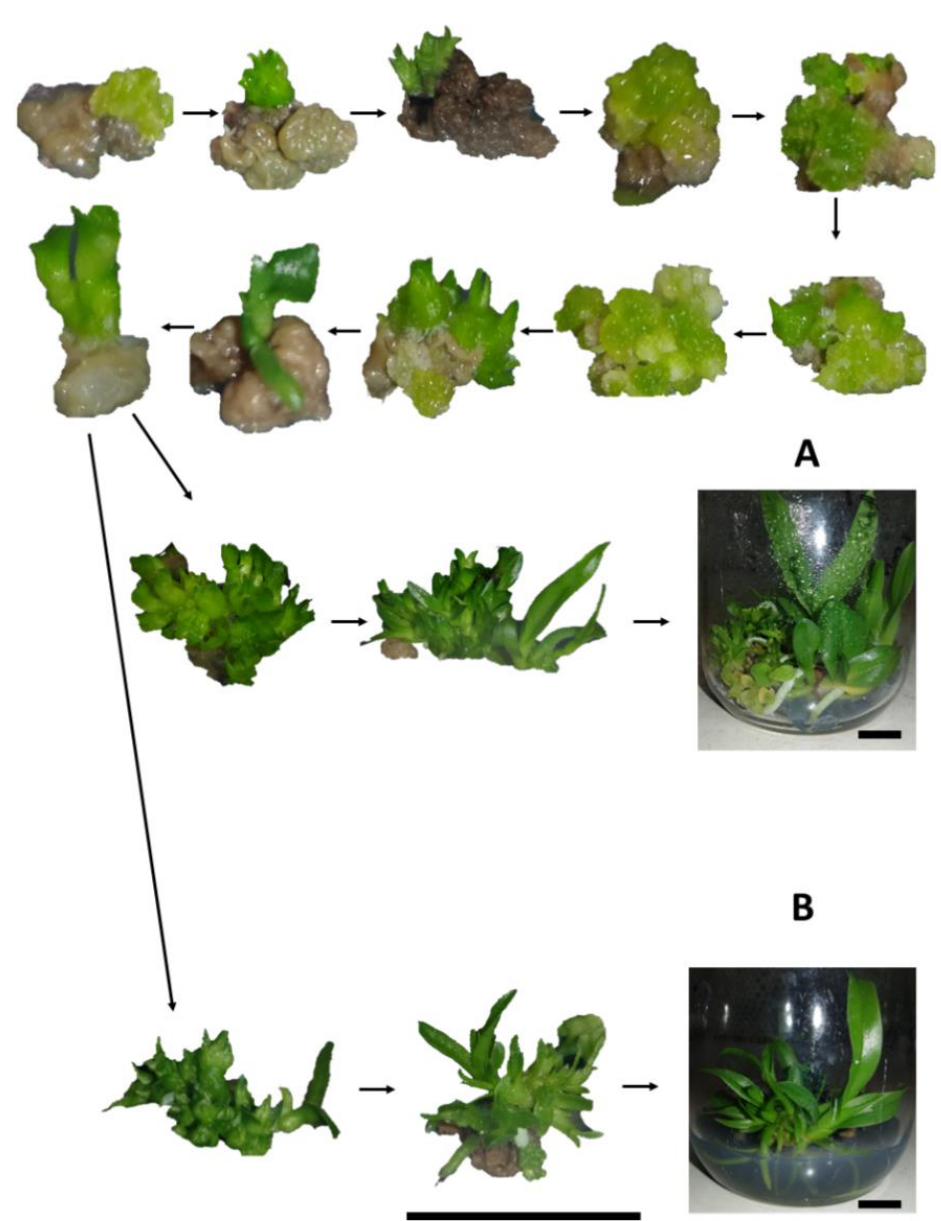
Figure 2. Regeneration of progeny of Blc . Haw Yuan Beauty × Blc . Goldenzelle “LC” in response to colchicine treatment of protocorms: ( A ) plantlets regenerated from protocorms treated with colchicine; ( B ) plantlets regenerated from protocorms not treated with colchicine. Scale bar = 1 cm. In general, polyploidized plants presented different morphology and architecture compared to non-polyploidized plants (Figure 5). Polyploid plants had oblong-shaped leaves with greater thickness, width and intensity of green color (Figure 5A), unlike non- polyploid plants, which showed lanceolate-shaped leaves with lower width, thickness and a light green color (Figure